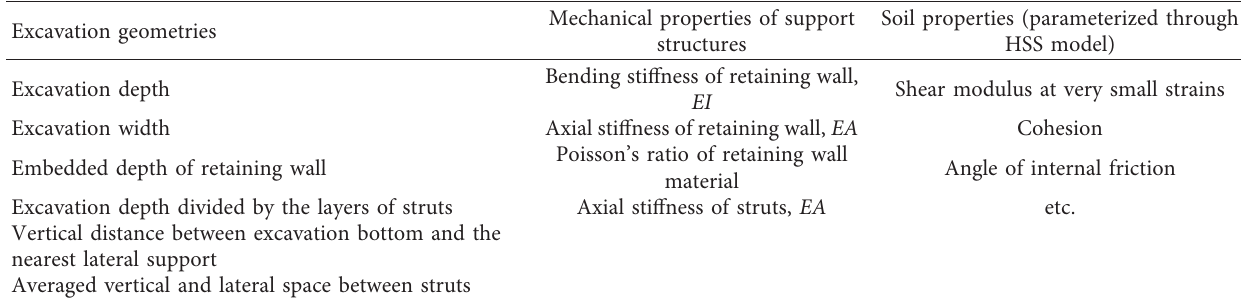
Figure 3: Layered structure of the proposed neural Table 1: ANN input layer.